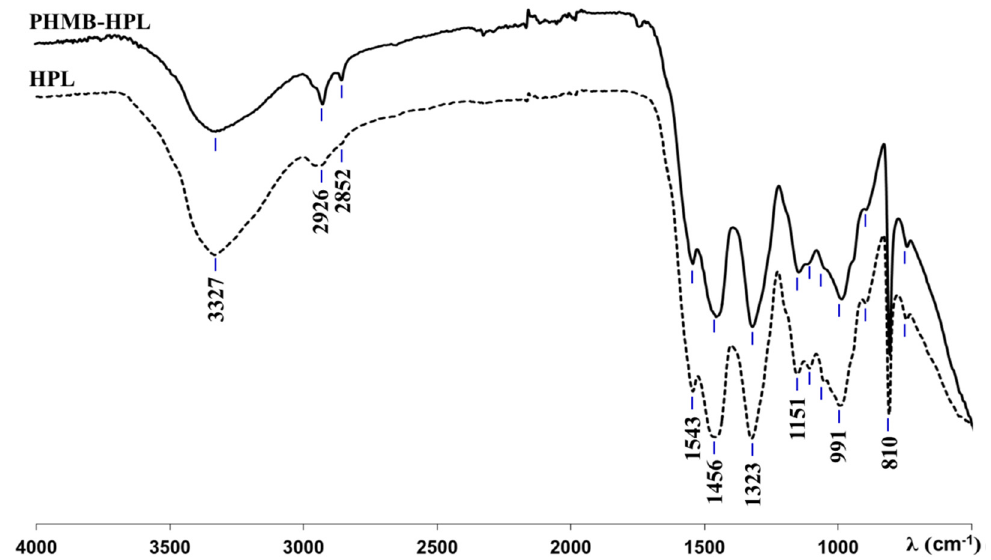
Figure 4. ATR ‐ FTIR spectra of standard HPL and PHMB ‐ HPL (2.4%(IN) SAS). Figure 4. ATR-FTIR spectra of standard HPL and PHMB-HPL (2.4%(IN) SAS).